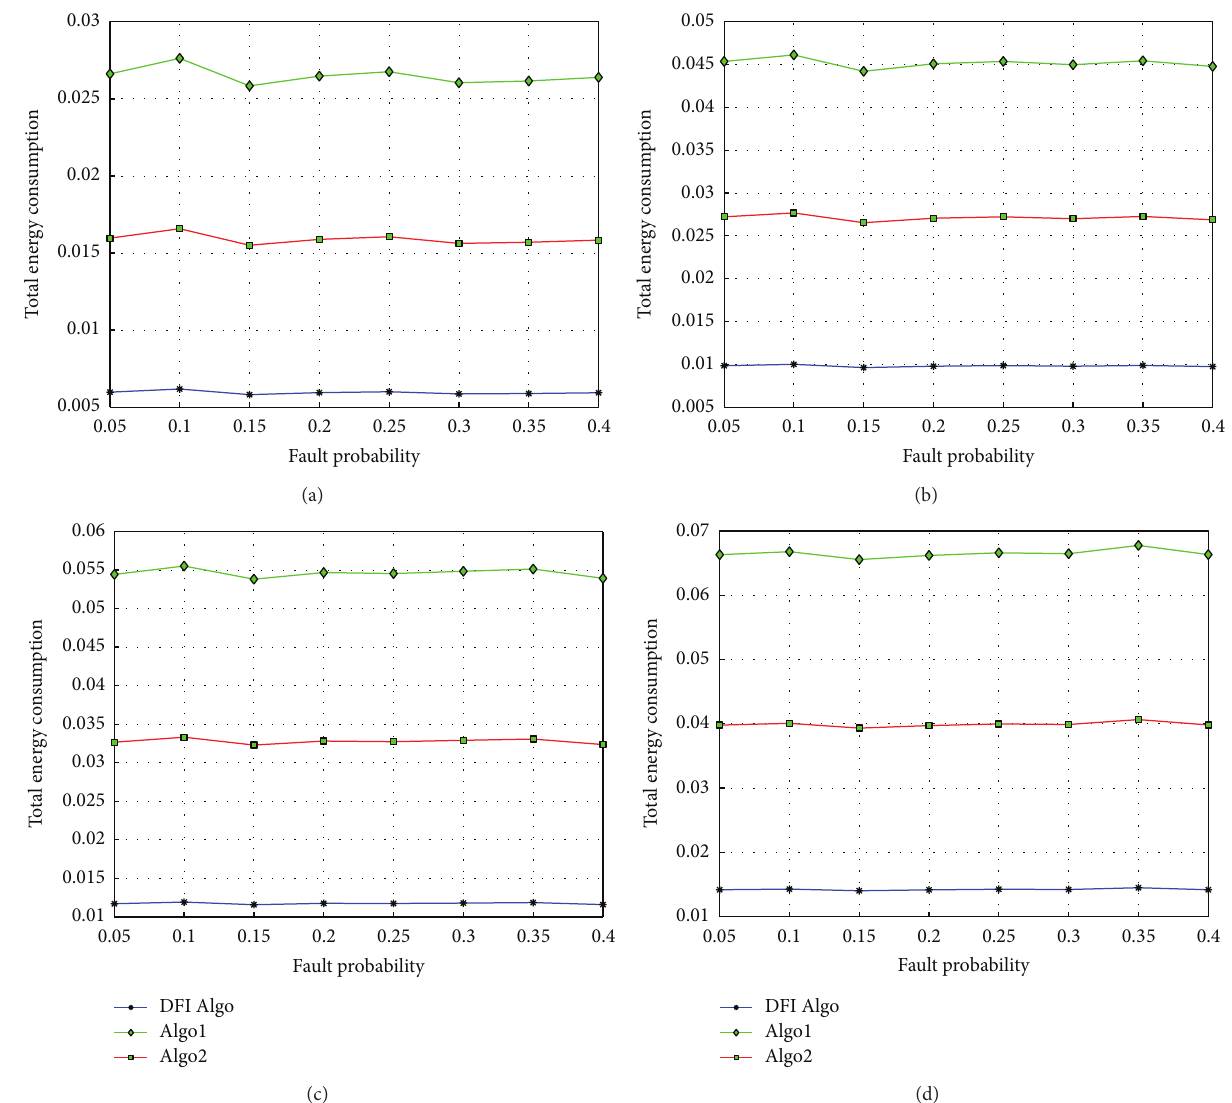
Figure 5: Total energy consumption versus fault probability for the DFI, JSA, and Jiang algorithms: (a) for average degree 𝑁 𝑎 = 10; (b) for average degree 𝑁 𝑎 = 15; (c) for average degree 𝑁 𝑎 = 20; (d) for average degree 𝑁 𝑎 =